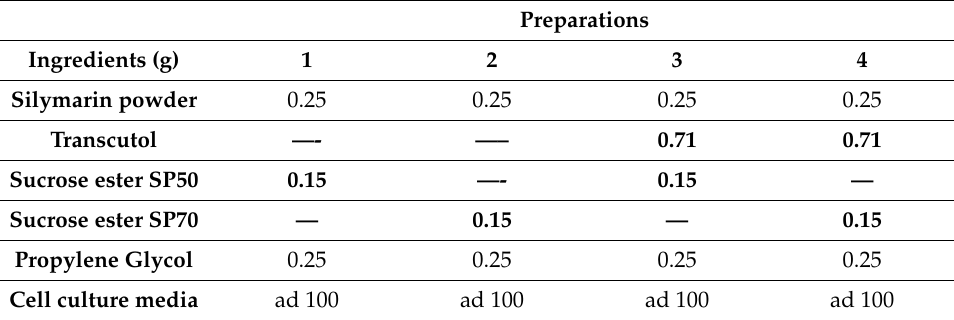
Table 1. Preparation of compositions containing silymarin powder with penetration enhancers. Ingredients